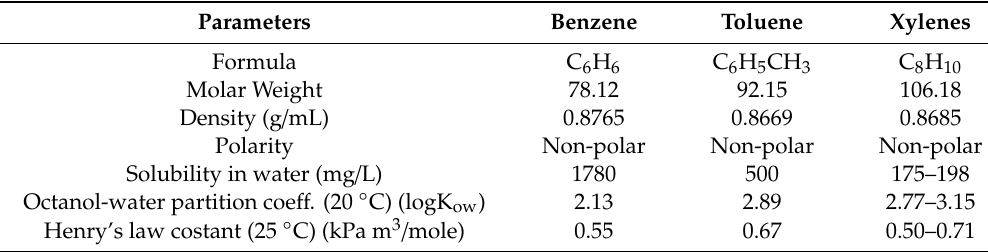
Table 1. Physico-chemical properties of